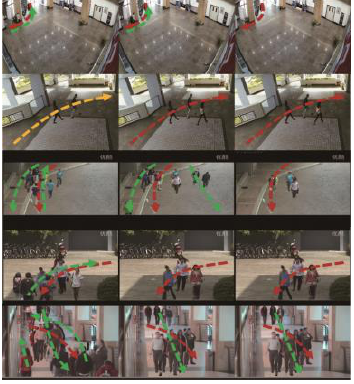
Fig. 8. Grouping effect of each